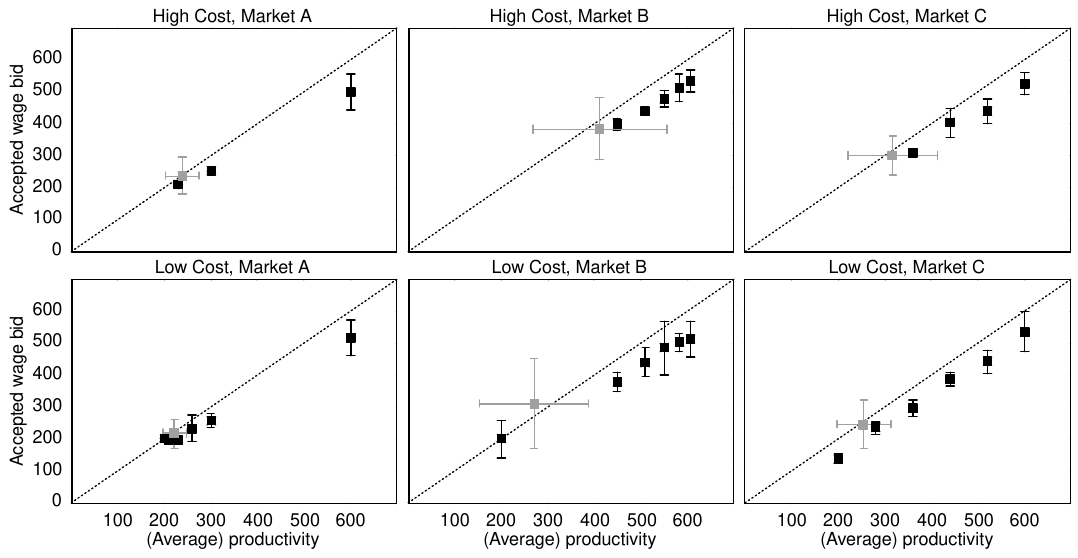
Figure 4. Accepted wage bids depending on the information set reached. The black entries represent the singleton information sets H 1 ,..., H 6 that are reached if a worker of the corresponding type reveals. The gray entries represent the non-singleton information set H C that is reached upon